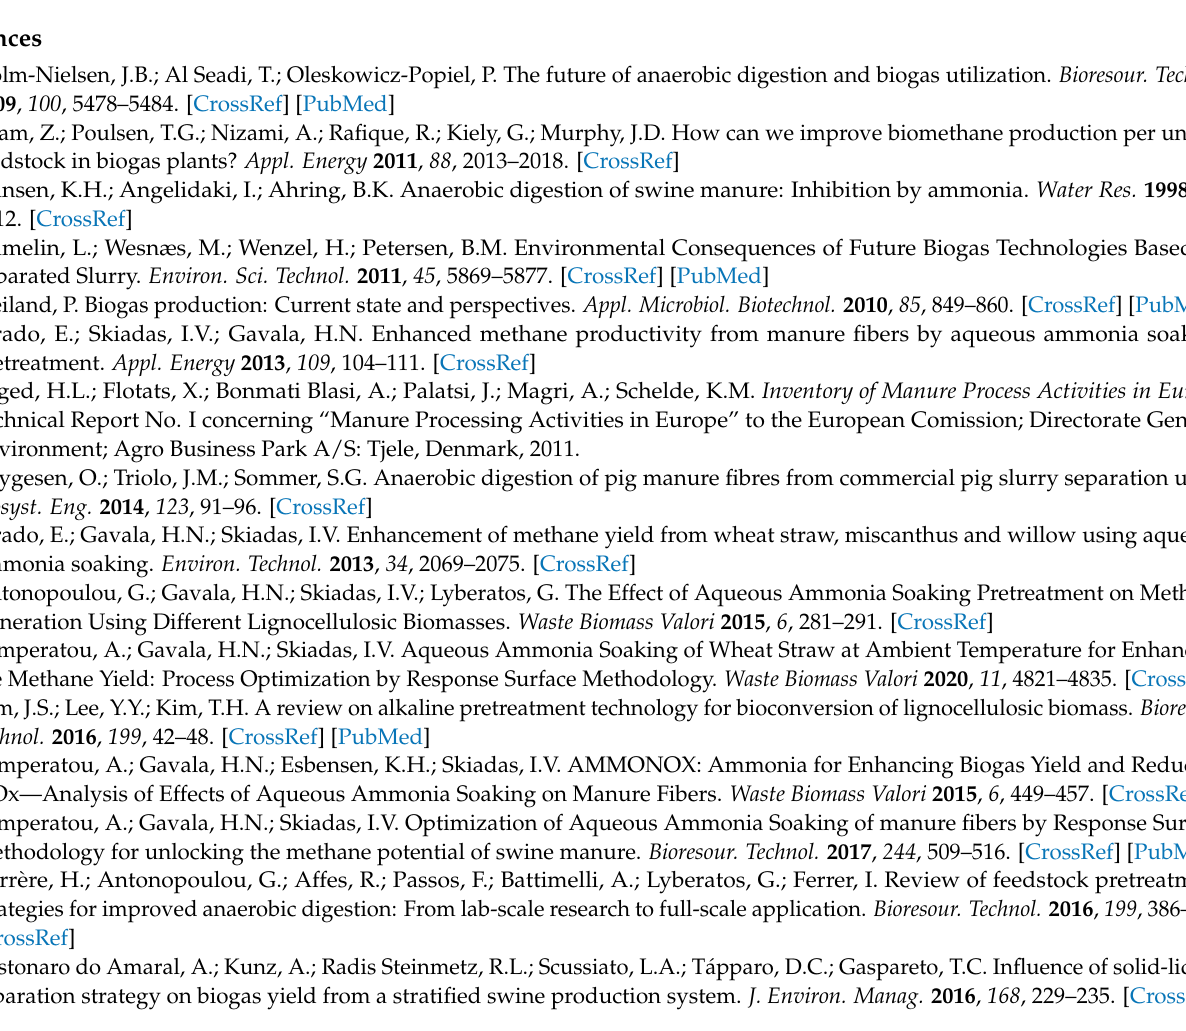
Table S4: Characteristics of Scenario 1 (manure mono-digestion) and Scenario 2 (AD of manure and NP fibers), Table S5: Increase of CH 4 yield achieved from BMPs of digested manure fibers for evaluating the efficiency of AAS at low temperature and with the addition of centrifuged